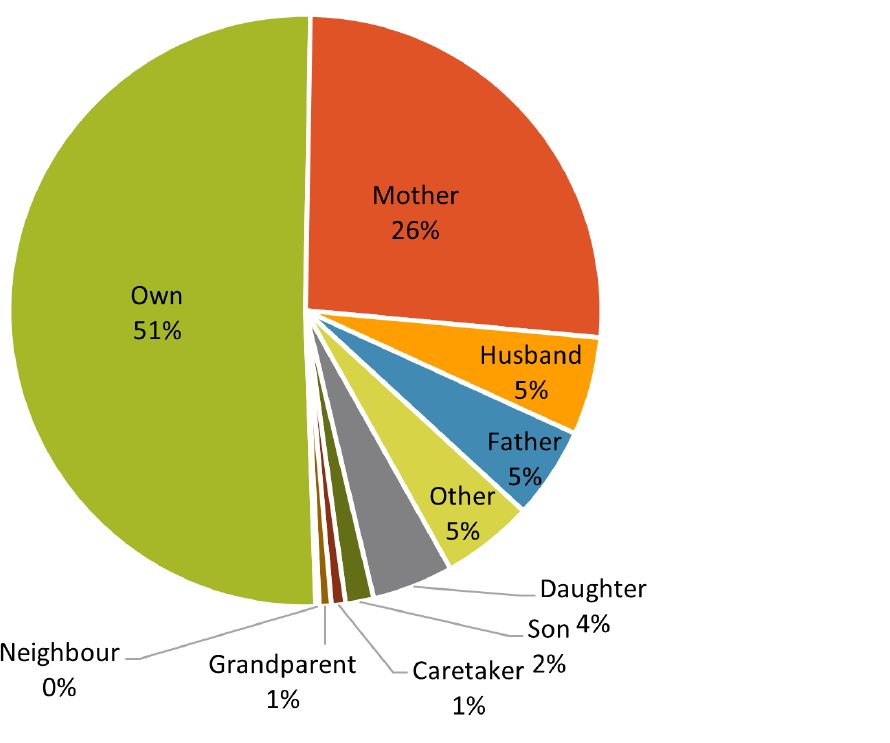
Figure 3. Distribution of calls by relation of the caller to the citizen.